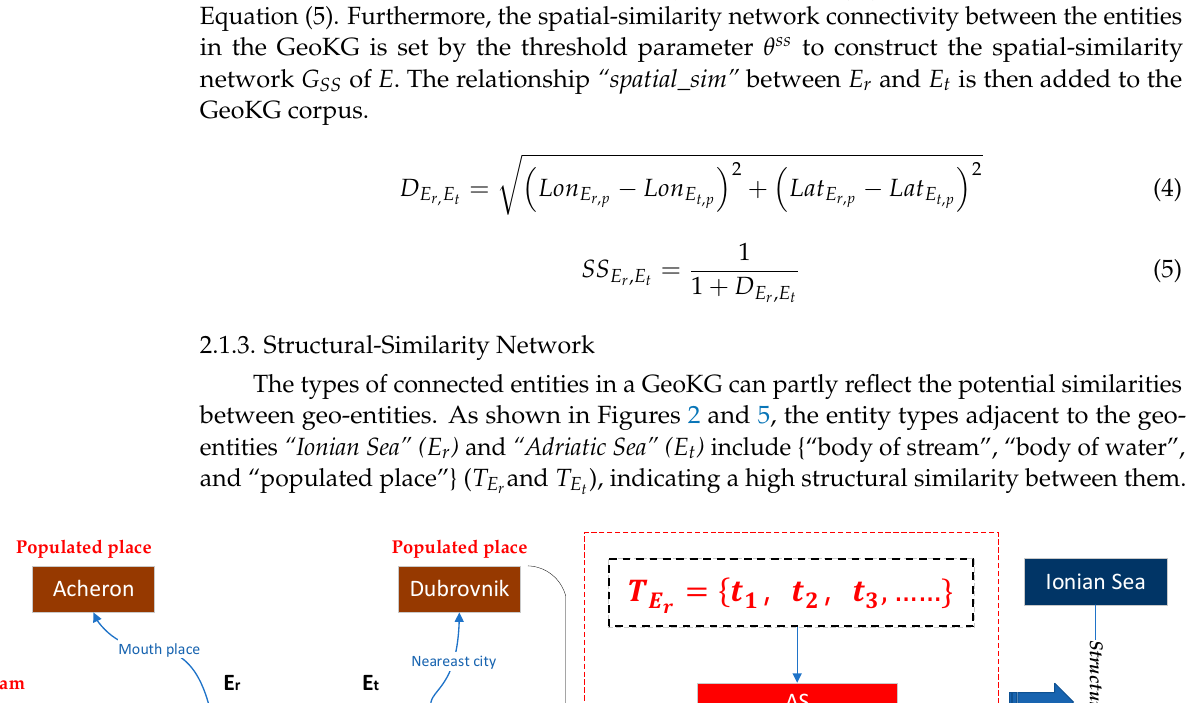
Figure 4. Visual space distance model.